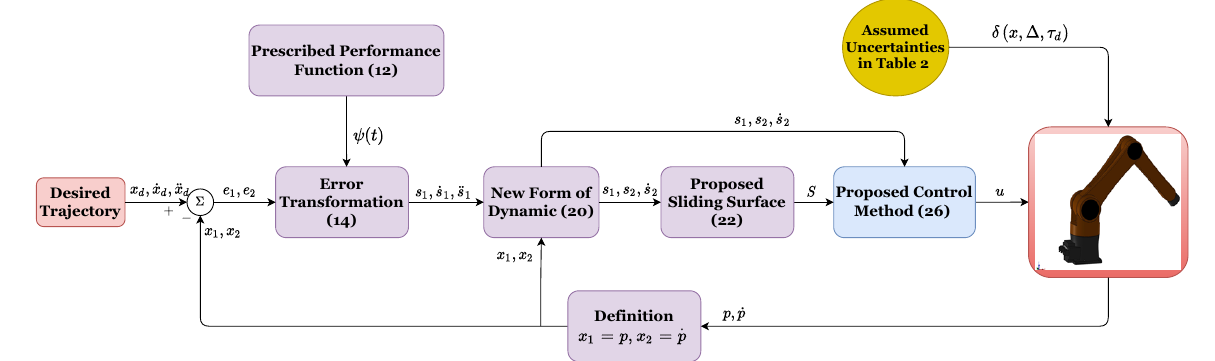
Figure 1. Algorithm diagram for the proposed control